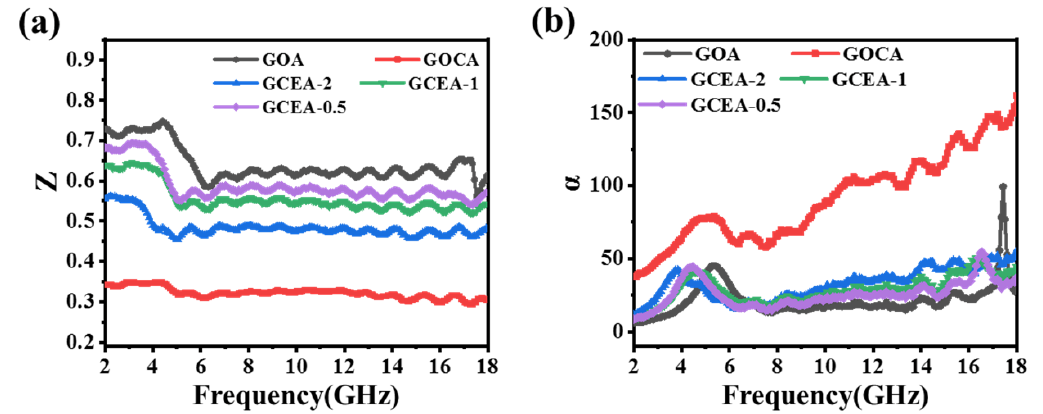
Figure 8. The reflection losses (RL) of the various samples in 2–18 GHz frequency range, ( a – c ), 2D plots ( d – f ) of GOA, GOCA, GCEA ‐ 2 with effective absorption bandwidth. frequency dependence of ( g ) ε ′ , ( h ) ε ″ , ( i ) tan δ ε (Color figure can be viewed online).